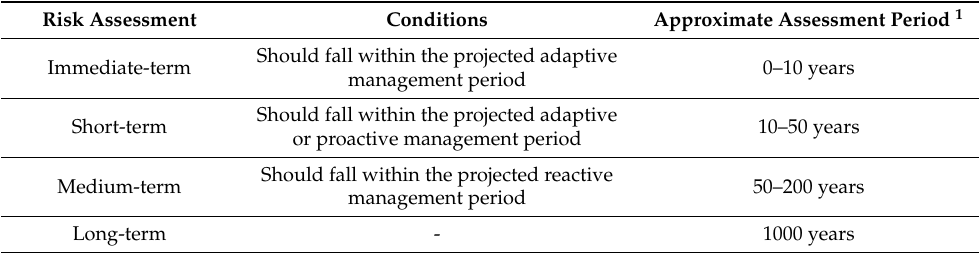
Table 4. Time frames for various levels of risk